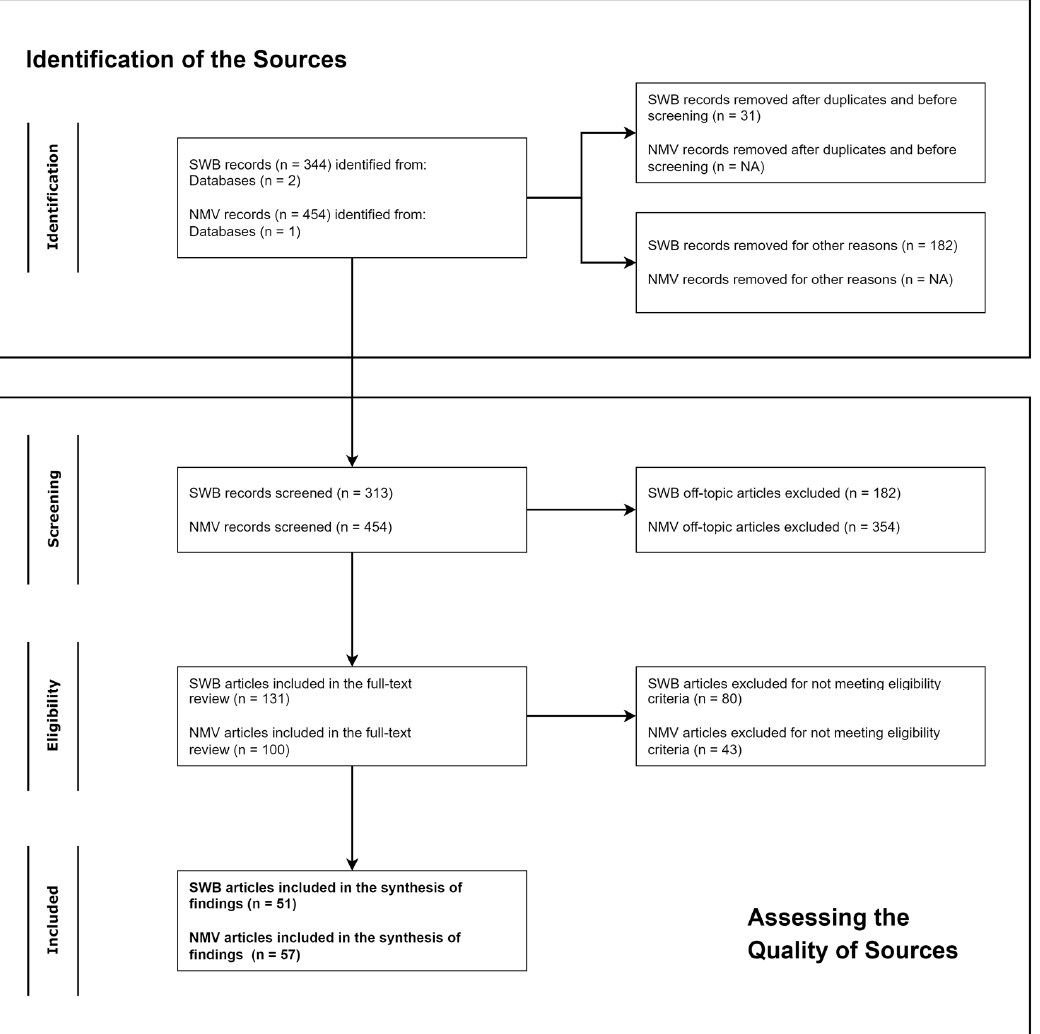
Figure 1. Flow chart of the methodological process followed to execute the review of the articles, based on the PRISMA method.